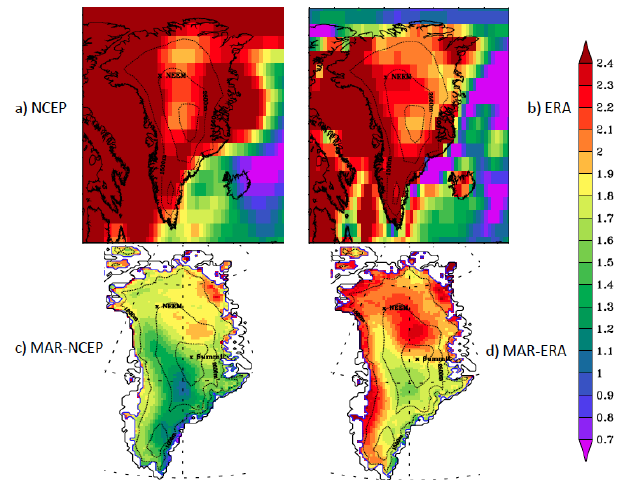
Figure 12. Map of surface air temperature change calculated from 1979 to 2011 (a) NCEP, (b) MAR-NCEP, (c) ERA-Interim, (d)